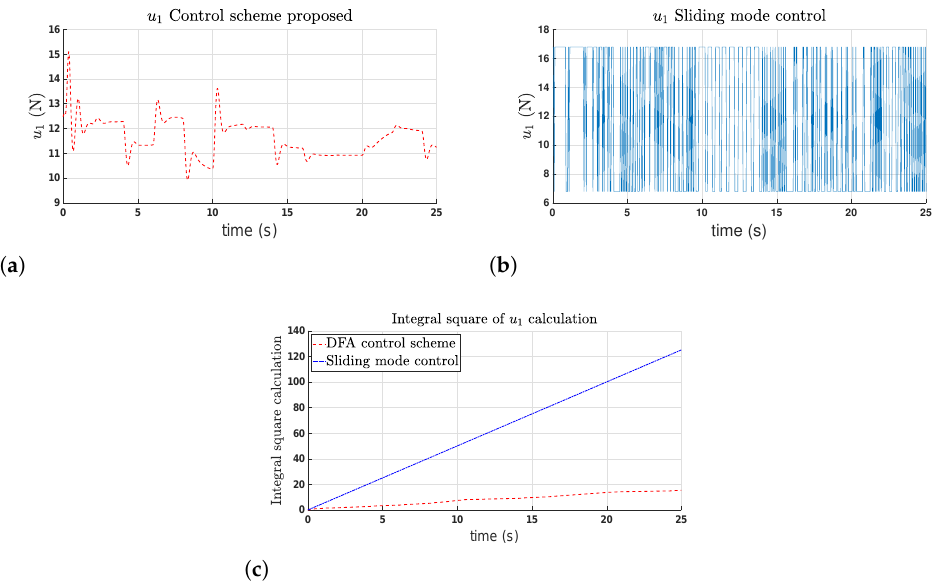
Figure 10. u 1 behavior for the implemented control schemes. ( a ) u 1 behavior (proposed control); ( b ) u 1 behavior (sliding mode control); ( c ) integral square index of u 1